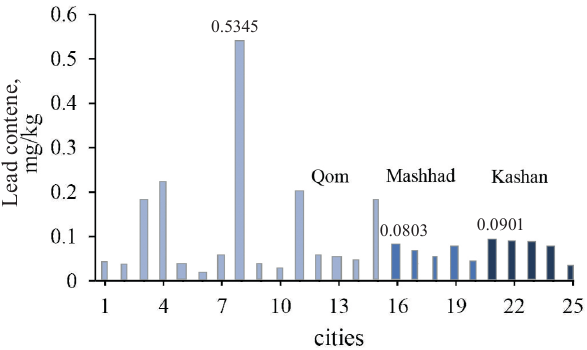
Figure 1 Comparison of international lead standard with lead contents in the egg samples under study (mean ± standard deviation)